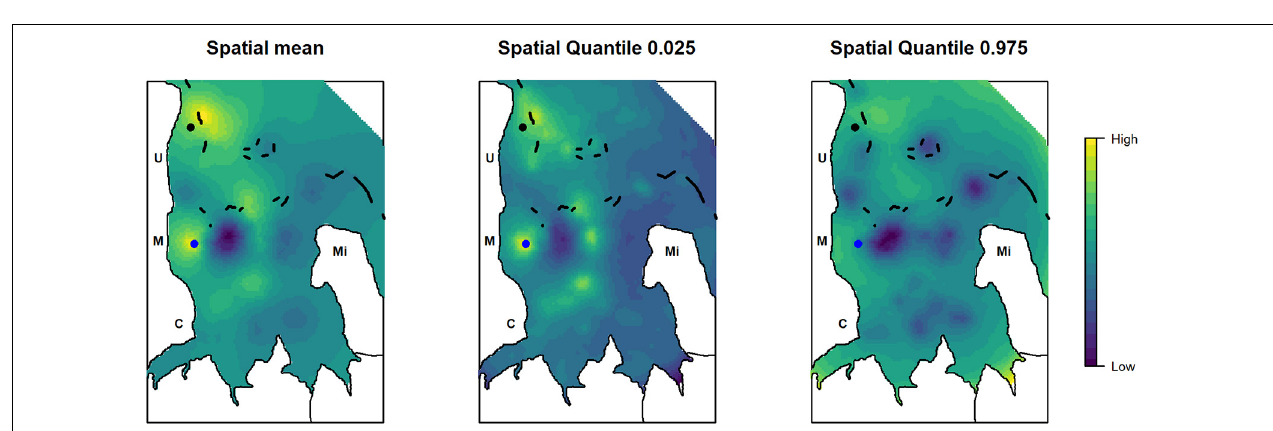
FIGURE 5 | Functional response of the weight per unit of effort of each species to their main environmental drivers. Solid lines and shaded regions are the mean and 95% credibility intervals, respectively. NEMS stands for North–East Monsoon Season and SEMS for South–East Monsoon Season.